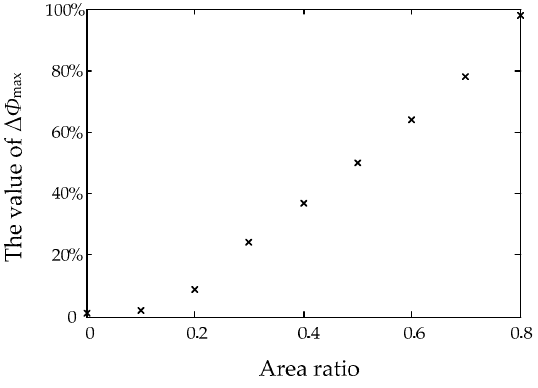
Figure 9. The value of Δ Φ max under different area ratio.